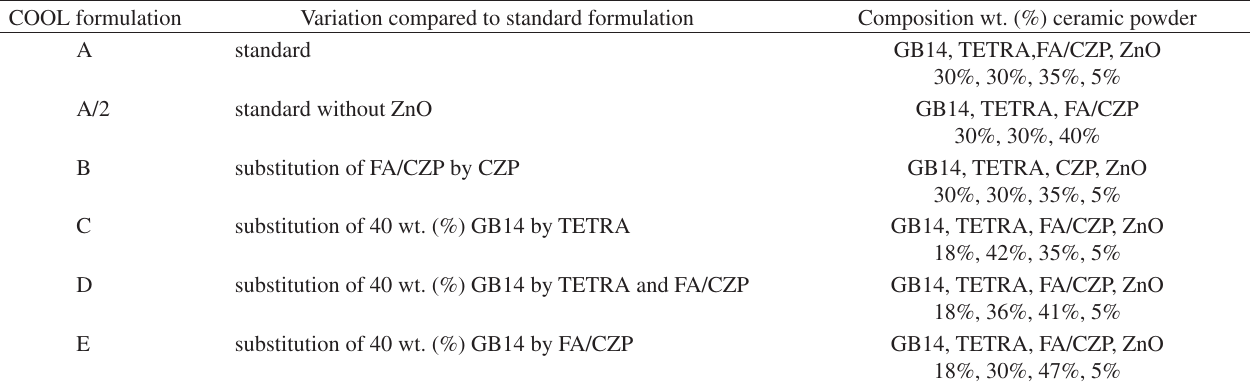
Table 1. Composition of different COOL formulations. COOL